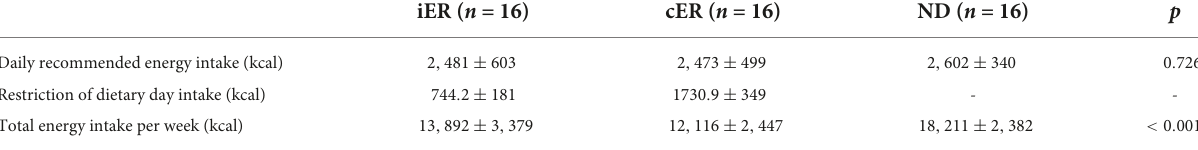
TABLE 1 Dietary intake during the intervention.